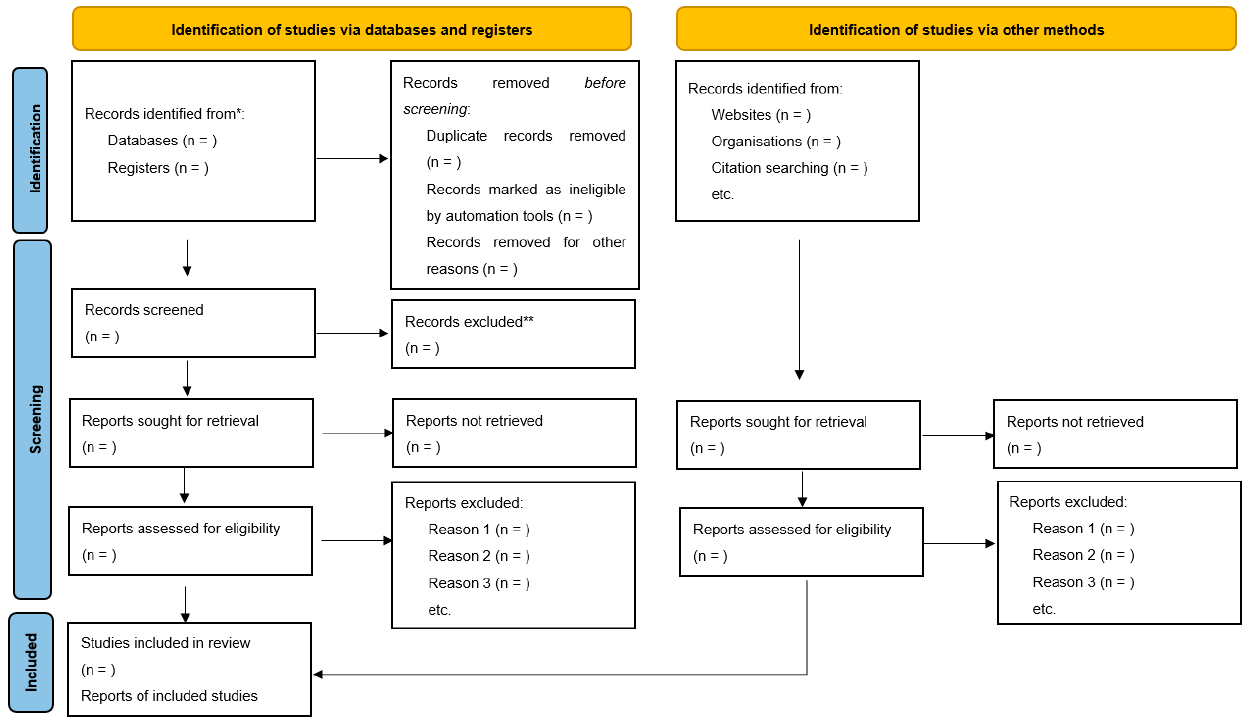
Figure 1. PRISMA 2020 flow